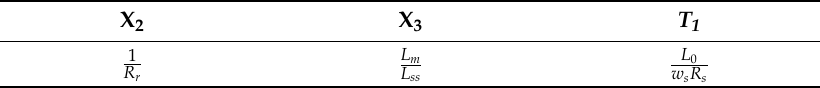
Table 1. Parameters for Figure 1.